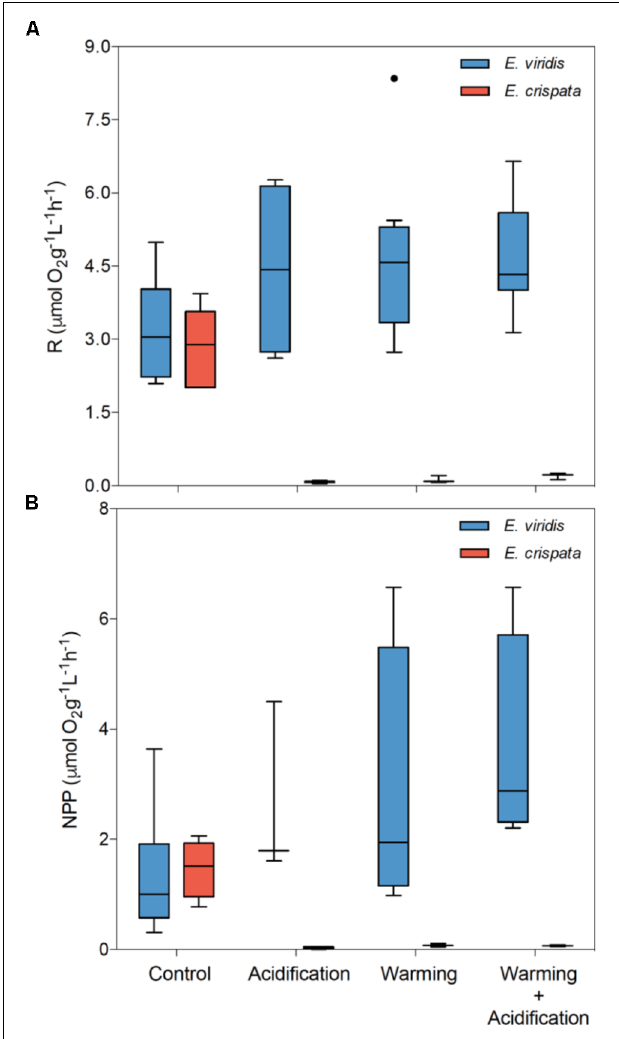
FIGURE 4 | Effects of ocean warming and acidification on the tropical E. crispata and the temperate E. viridis species. (A) R – respiration and (B) NPP – net primary production under different climate change, i.e., control (18 and 26 ◦ C, pH8.0); acidification (18 and 26 ◦ C, pH7.6); warming (22 and 30 ◦ C, pH8.0) and acidification + warming (22 and 30 ◦ C, pH7.6) experimental treatments. Tukey box-plots show median, percentile 25th and 75th, and – 1.5 times IQR and + 1.5 times IQR, respectively.